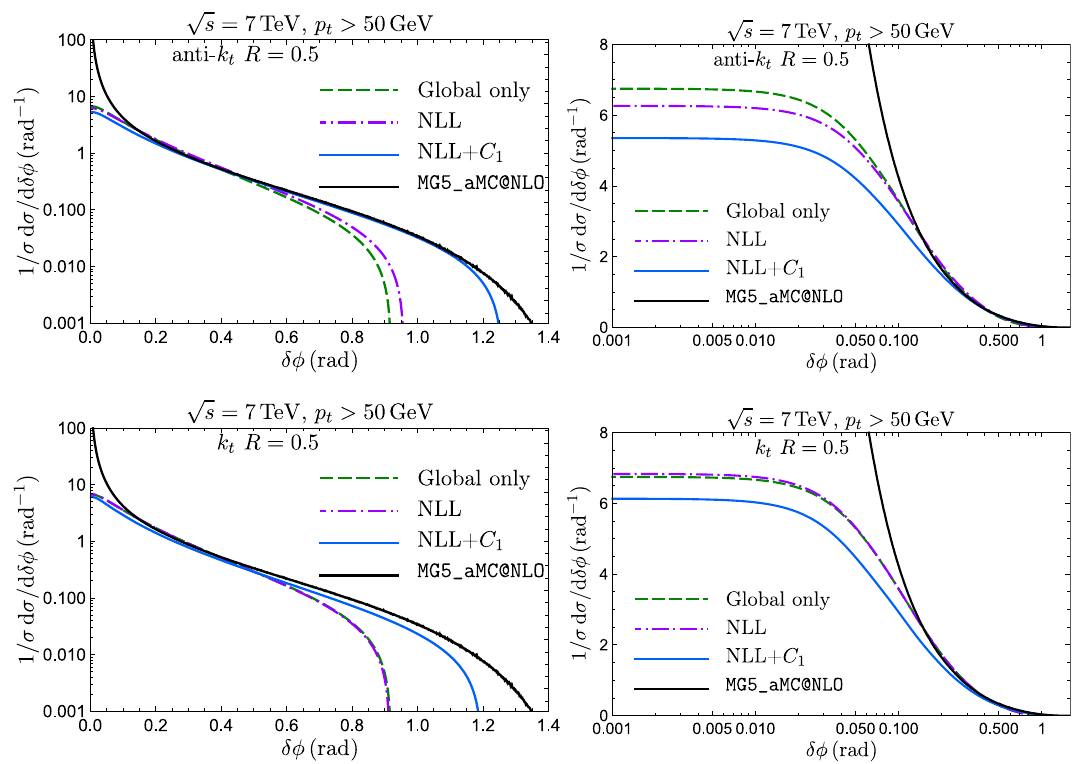
Figure 6 . The differential distribution 1 /σ d σ/ d δφ with anti- k t clustering (top) and k t clustering (bottom). We show here the global resummed distribution without NGLs/CLs, the full NLL resummed distribution (including NGLs/CLs), and the corrected NLL distribution including the constant C . Also shown is the fixed-order MC result at 1